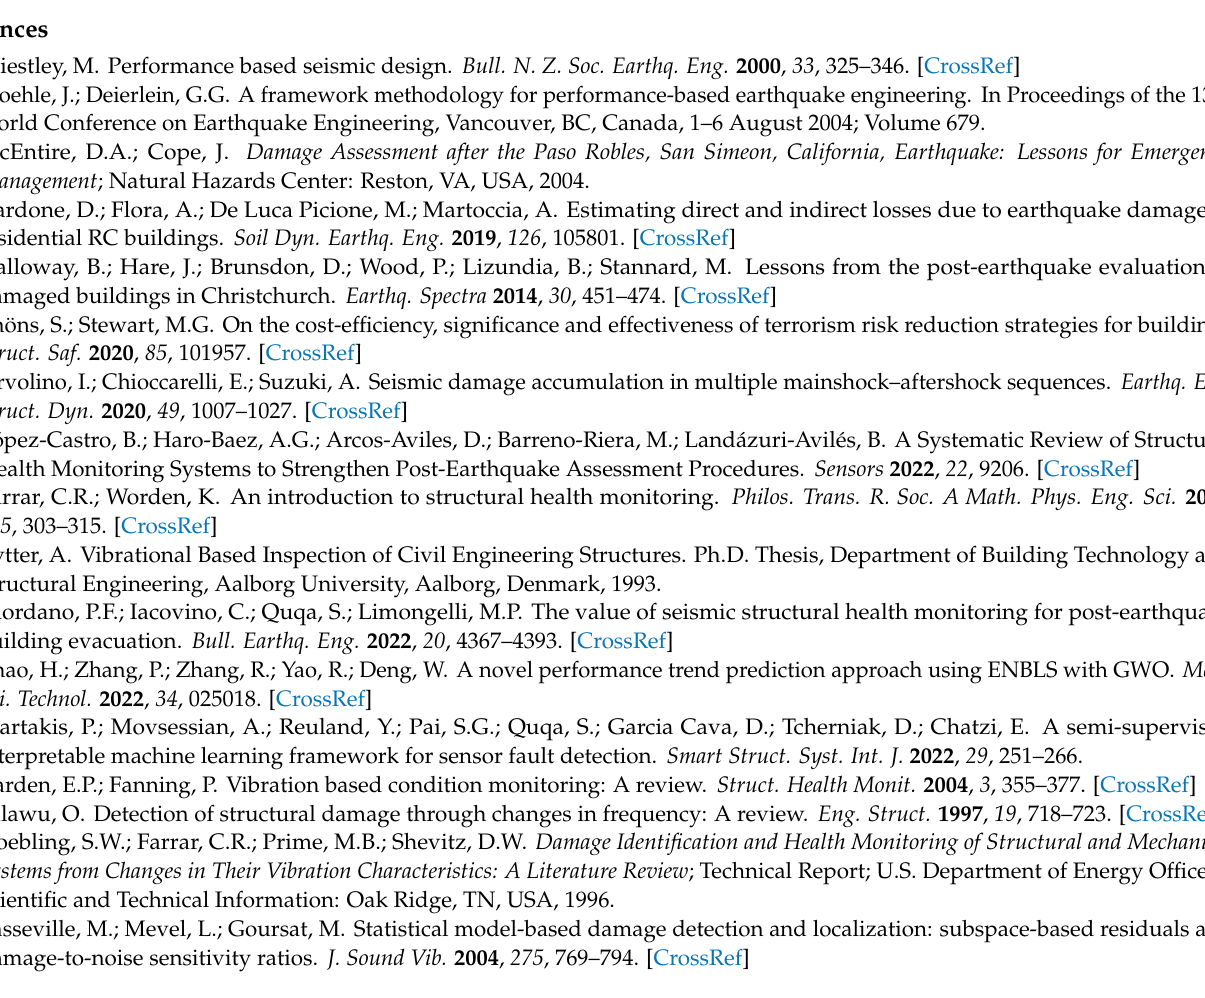
Figure A2. Comparison of the nonlinearity indicators for the shake-table tests performed by Beyer et al. [90] ( left ) and their contribution to the increment to the Park and Ang damage in- dex ( right